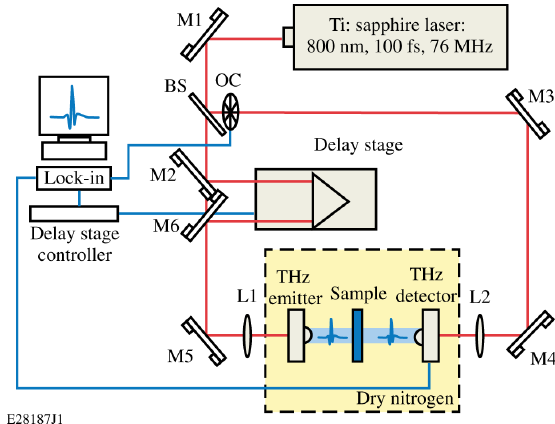
Figure 4. Schematic diagram of a THz-TDS setup. L1, L2: optical lenses; M1–M6: dielectric mirrors; BS: beam splitter, and OC: optical chopper.